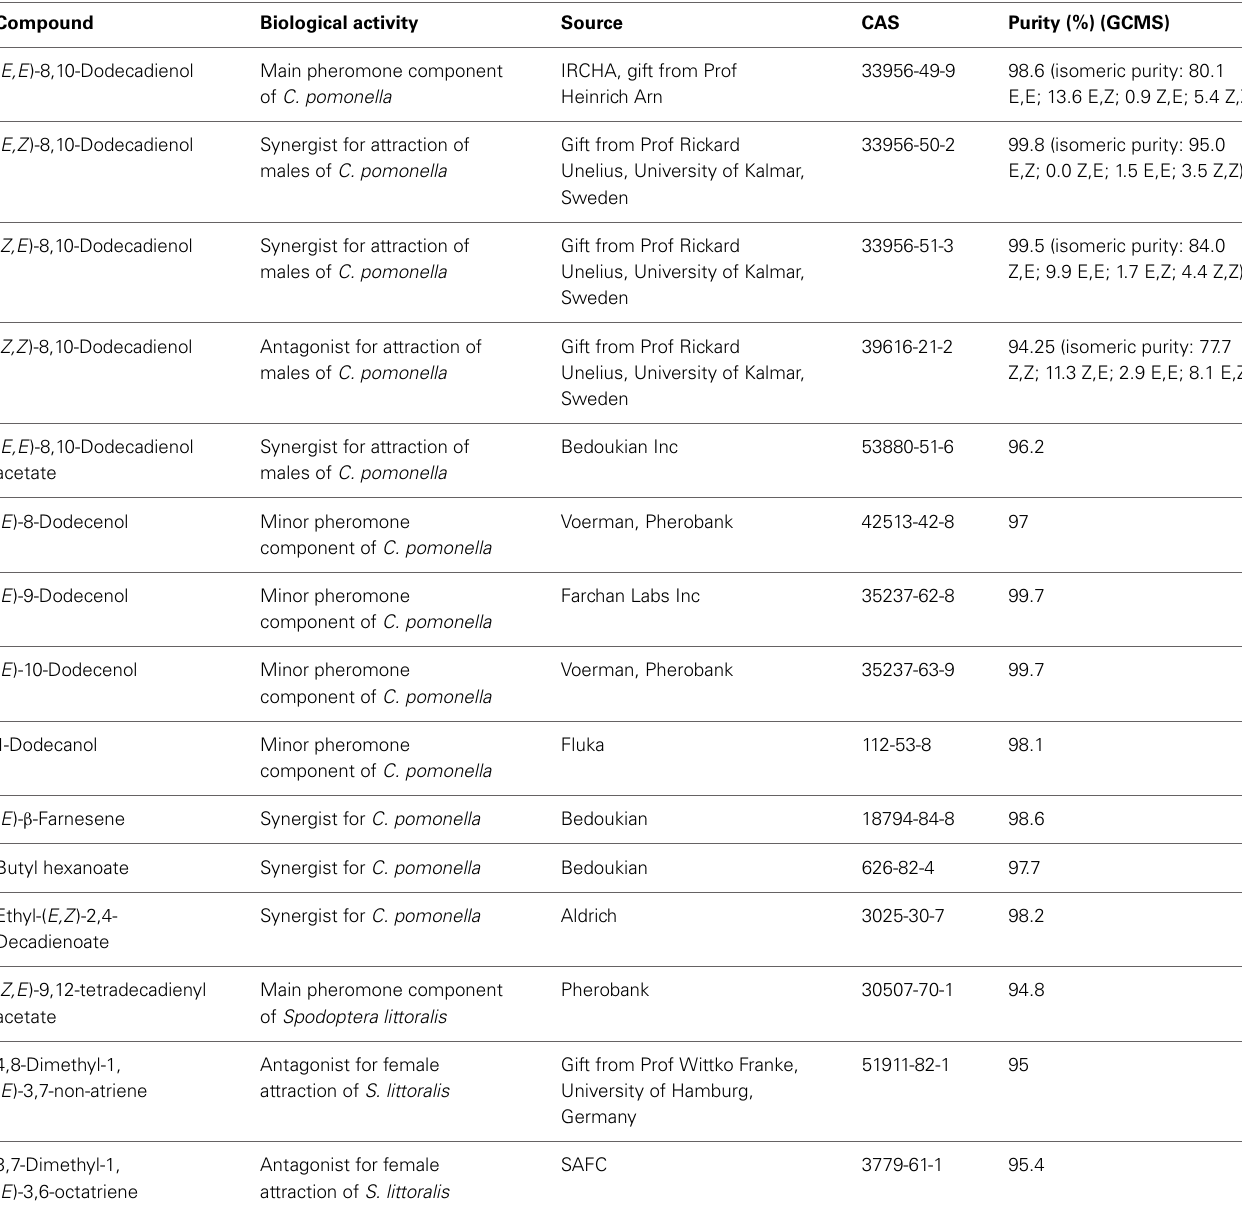
Table 1 | Synthetic compounds tested on CpomOR3.